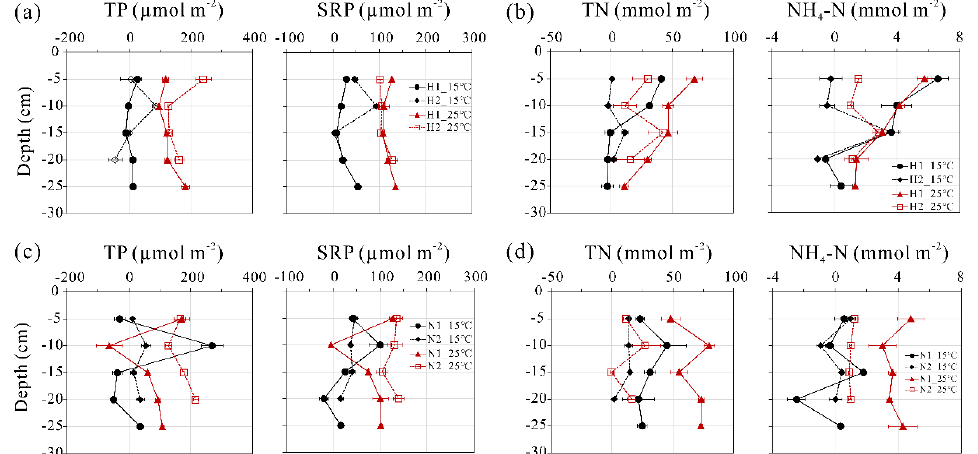
Figure 4. Apparent fluxes of dissolved total P (TP), total N (TN), soluble reactive P (SRP), and ammonium (NH 4 -N) during the 20-day incubation at 15 °C and 25 °C from sediments, by depth, at each sampling site from Hongchaojiang (HCJ) ( a , b ) and Niuweiling (NWL) ( c , d ) reservoirs. Water 2022 , 14 , x FOR PEER REVIEW